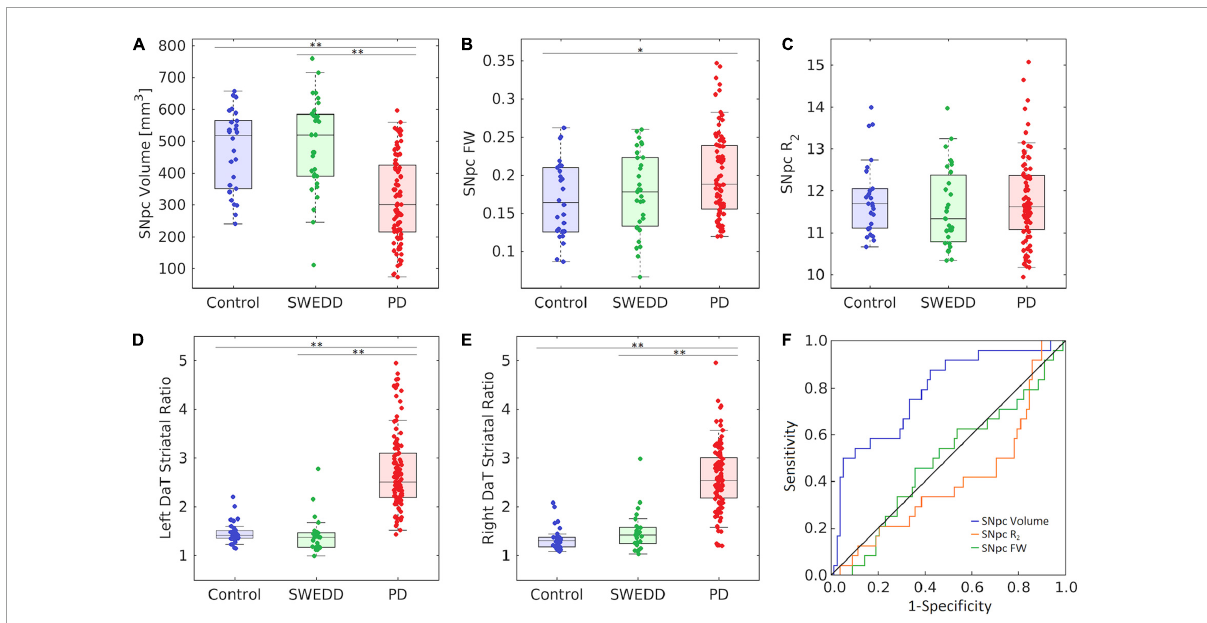
FIGURE3 Group comparisons for substantia nigra pars compacta (SNpc) volume (A) , SNpc free water (FW) (B) , SNpc R 2 (C) , left DaT striatal uptake ratio (D) , and right DaT striatal uptake ratio (E) in control, SWEDD, and PD groups. AUC curves for SNpc volume, mean SNpc FW, and mean SNpc R 2 are shown in panel (F) . SNpc volume outperformed mean SNpc FW and mean SNpc R 2 as a diagnostic marker to differentiate SWEDD from PD. All box plots, the top and bottom of the box denote the 25th and 75th percentiles, respectively, with the line denoting the median value. In panels (A–F) ∗ P < 0.05 and ∗∗ P <